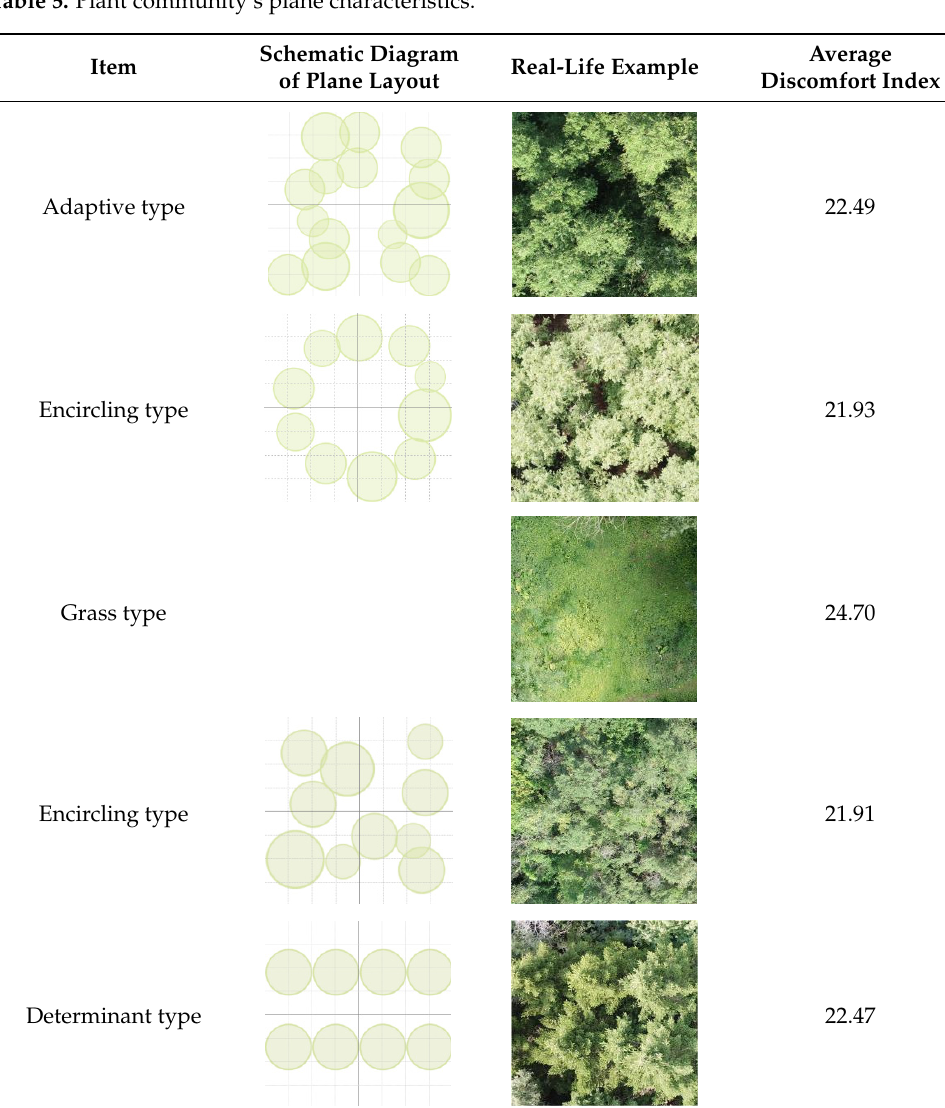
Table 5. Plant community’s plane